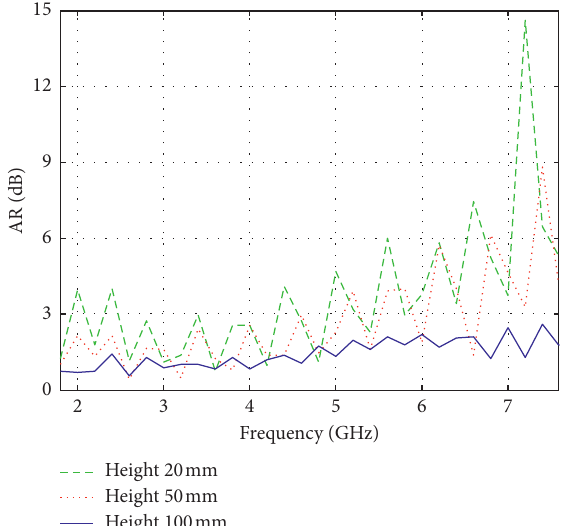
Figure 18: Simulated ARs of the SAAS antennas with different heights of cavity.